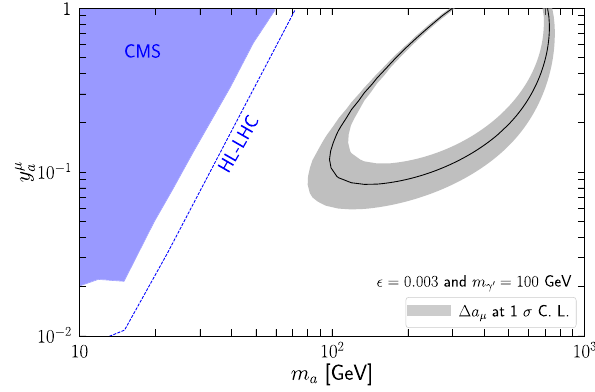
Fig. 6 The allowed ALP region for explaining the muon g − 2 with the fixed dark photon parameters (cid:7) = 0 . 003 and m γ (cid:3) = 100 GeV at 1 σ CL